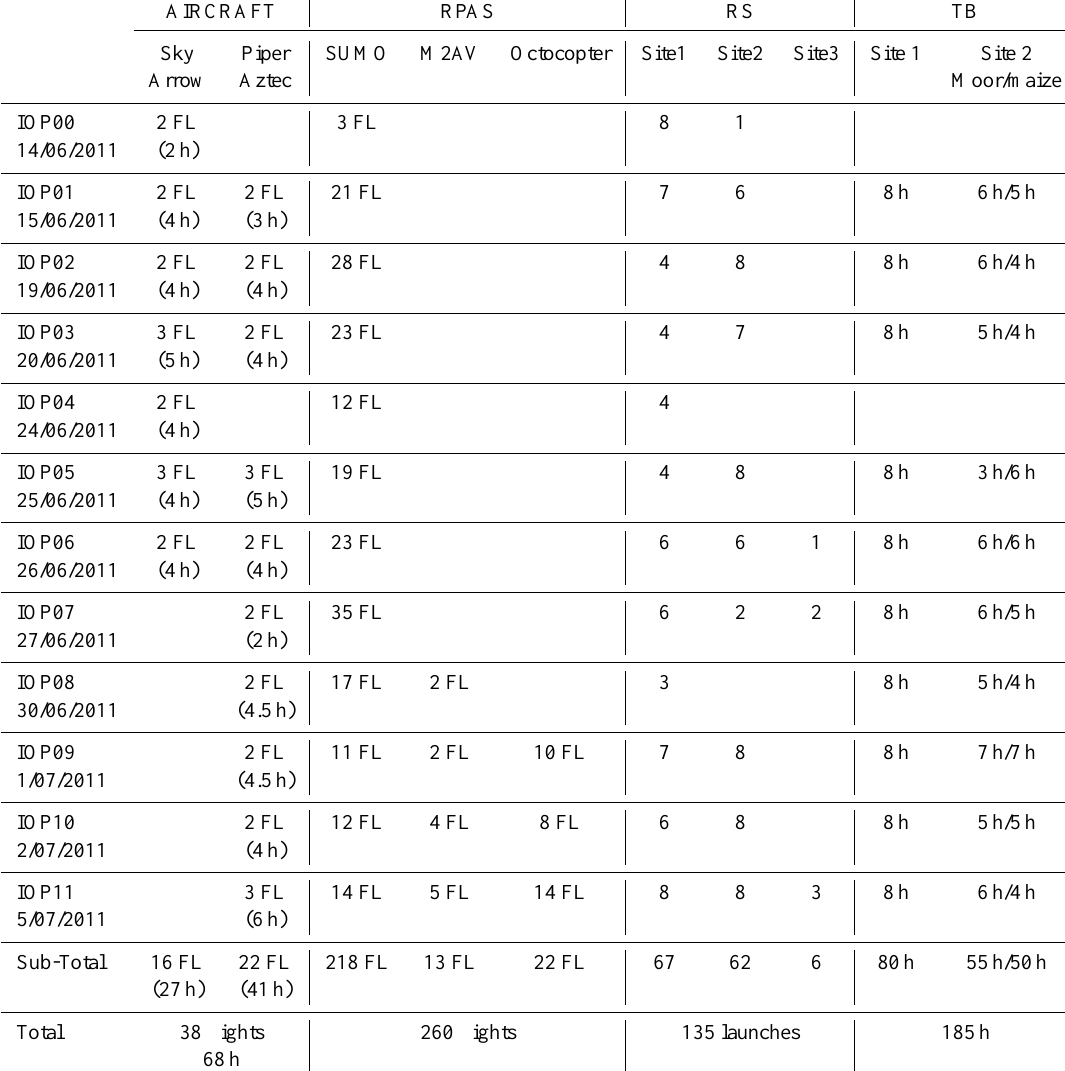
Table 2. Intensive observations made by the two aircraft (number of flights (FL) and hours), Remotely piloted aircraft system (RPAS) (number of flights), radiosoundings (RS) (number of launches), and tethered balloons (TB)